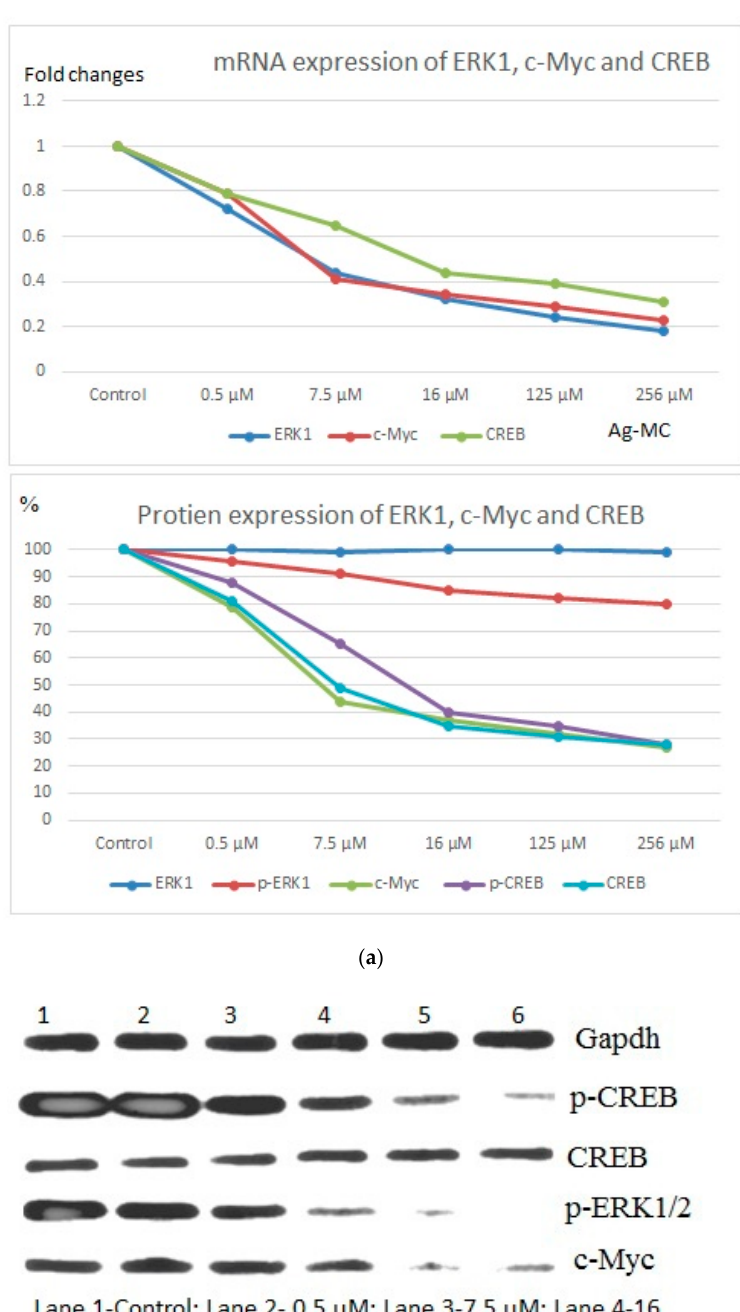
Figure 8. Effect of Ag-MC on mRNA and protein expression of ERK1, c-Myc and